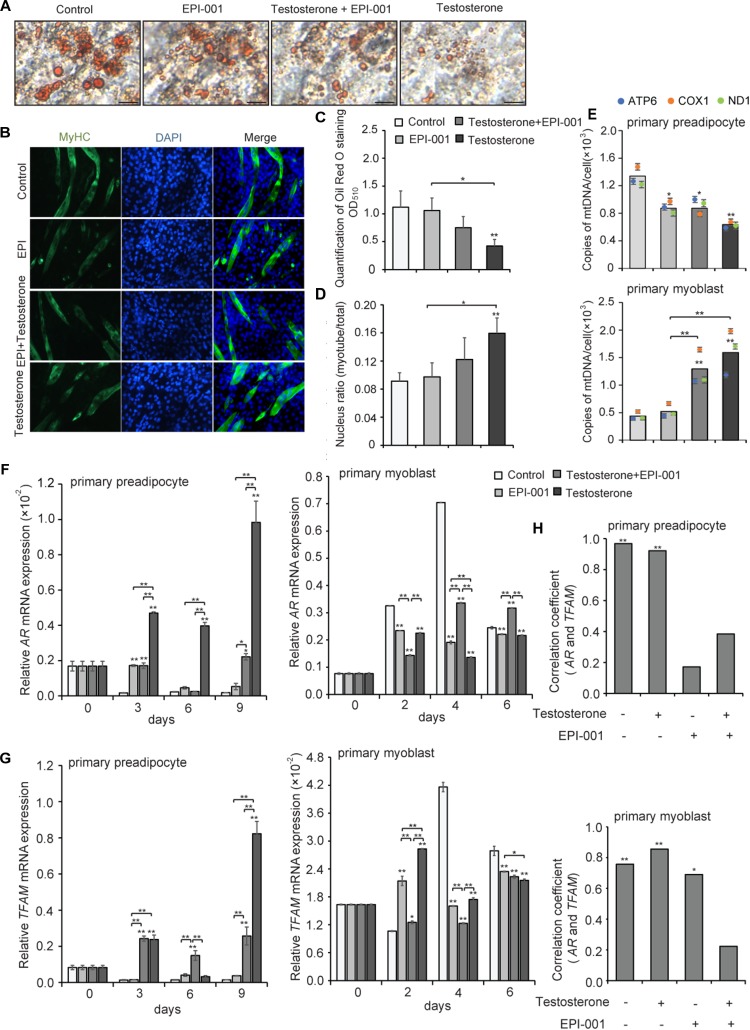
Effect of testosterone on pig primary cells during differentiation. (A) Oil Red O staining of adipocytes after treatment with testosterone (10-7 mol/L) and EPI-001 (10-4 mol/L) after differentiation for 9 day (scale bar = 50 μm). (B) Myotubes were stained with anti-MyHC antibody and the fusion index was calculated. Images were obtained by fluorescence microscopy on the 6th day of myoblast differentiation. (C) Quantification of Oil Red O staining. (D) Fusion index of myotube was calculated. (E) mtDNA copy number analysis of adipogenesis and myogenesis in four treatment groups. Twice the ratio of ATP6/COX1/ND1 to single-copy nuclear gene number reflected the relative mtDNA content, and the solid bars represent mean values of mtDNA contents individually calculated by ATP6, COX1, and ND1. (F)
AR and (G)
TFAM expression of adipogenesis and myogenesis. (H) Correlation analysis of AR and TFAM based on a Pearson correlation coefficient test during adipogenesis and myogenesis, treated with 10-7 mol/L testosterone (T), 10-4 mol/L EPI-001 (EPI), and 10-7 mol/L testosterone + 10-4 mol/L EPI-001 (T+EPI-001). All data are expressed as means ± SD. Tukey’s post hoc test. ∗P < 0.05, ∗∗P < 0.01 compared with the control (on the bars) or between the indicated groups.